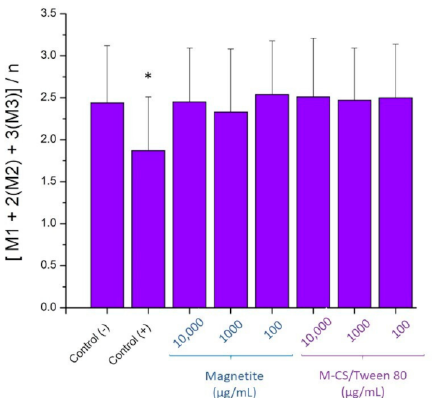
Figure 11. Proliferation index results of bare magnetite nanoparticles and chitosan/tween 80 microspheres loaded with mag- netite nanoparticles. There was a significative difference ( p = 0.05) between the positive control * versus the negative